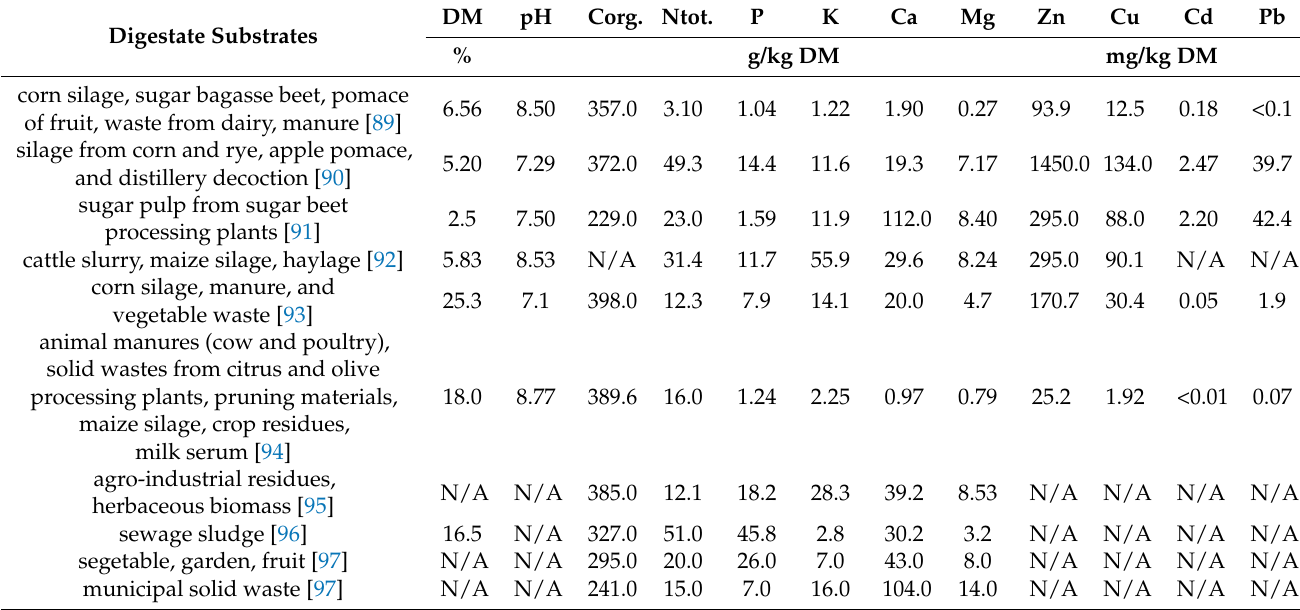
Table 6. Chemical composition of digestate from different